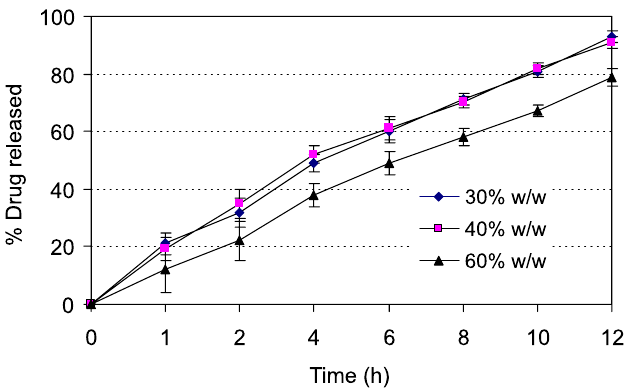
FIGURE 9 – Effect of pellet percentage ( -♦- ) 30% w/w, ( -■-) 40% w/w and (-▲-) 60% w/w in tablet composition on in vitro sertraline release.